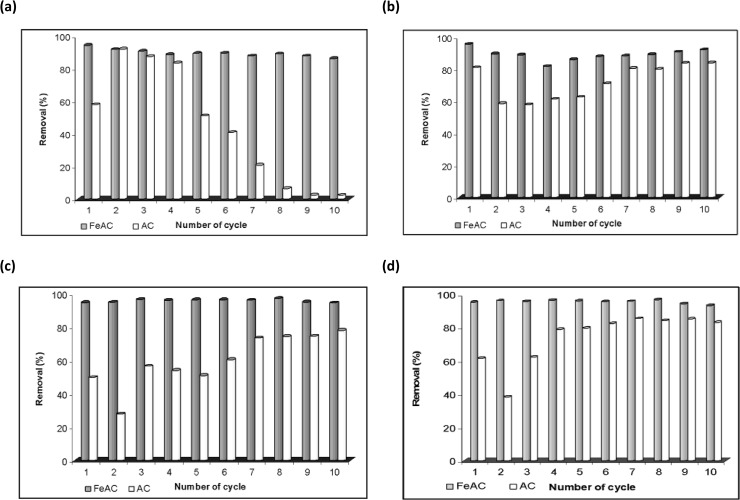
Regeneration studies of spent adsorbents using (a) H2SO4 (b) NaOH (c) NaNO3 (d) distilled water.